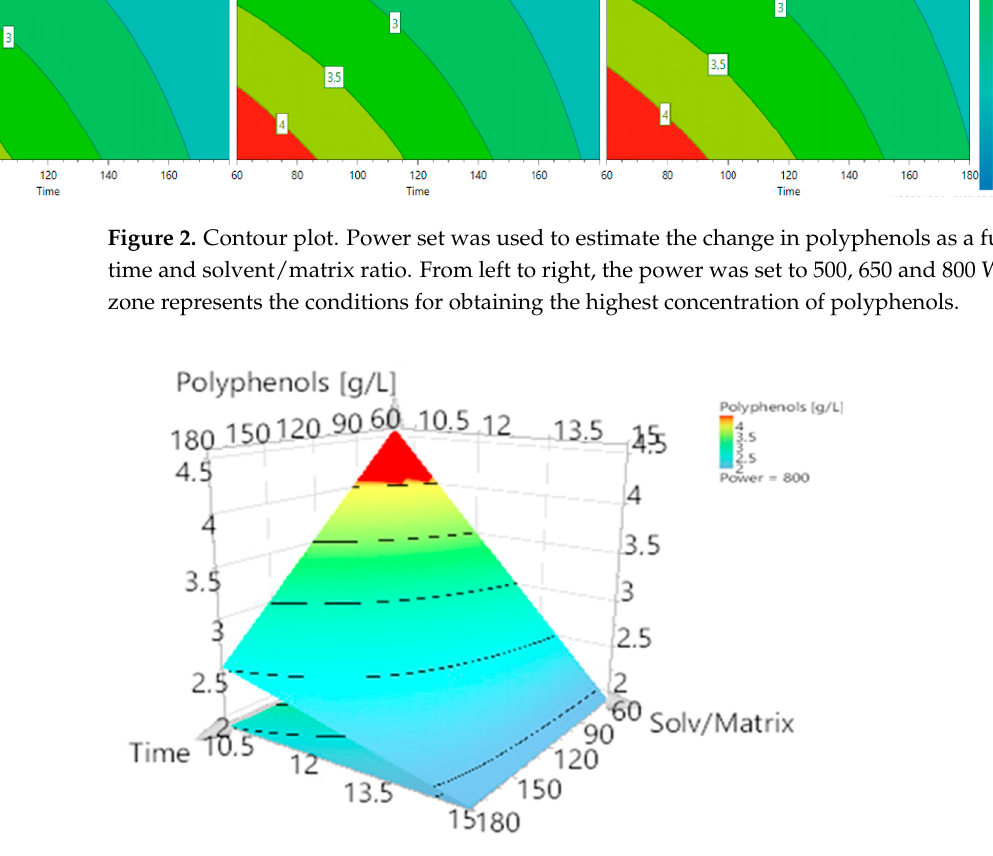
Figure 3. Response surface plot. Power of microwave was set to 800 W. From blue zone to red zone, the concentration of polyphenols increases.